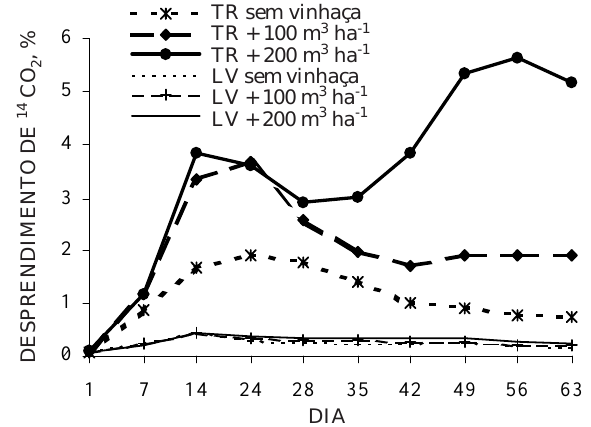
Figura 1. Desprendimento de 14 CO do diuron nos 2 solos Terra Roxa Estruturada (TR) e Latossolo Vermelho-Amarelo (LV), incubados com vinhaça até 63 dias. Coeficiente de variação £££££ 10,75%.